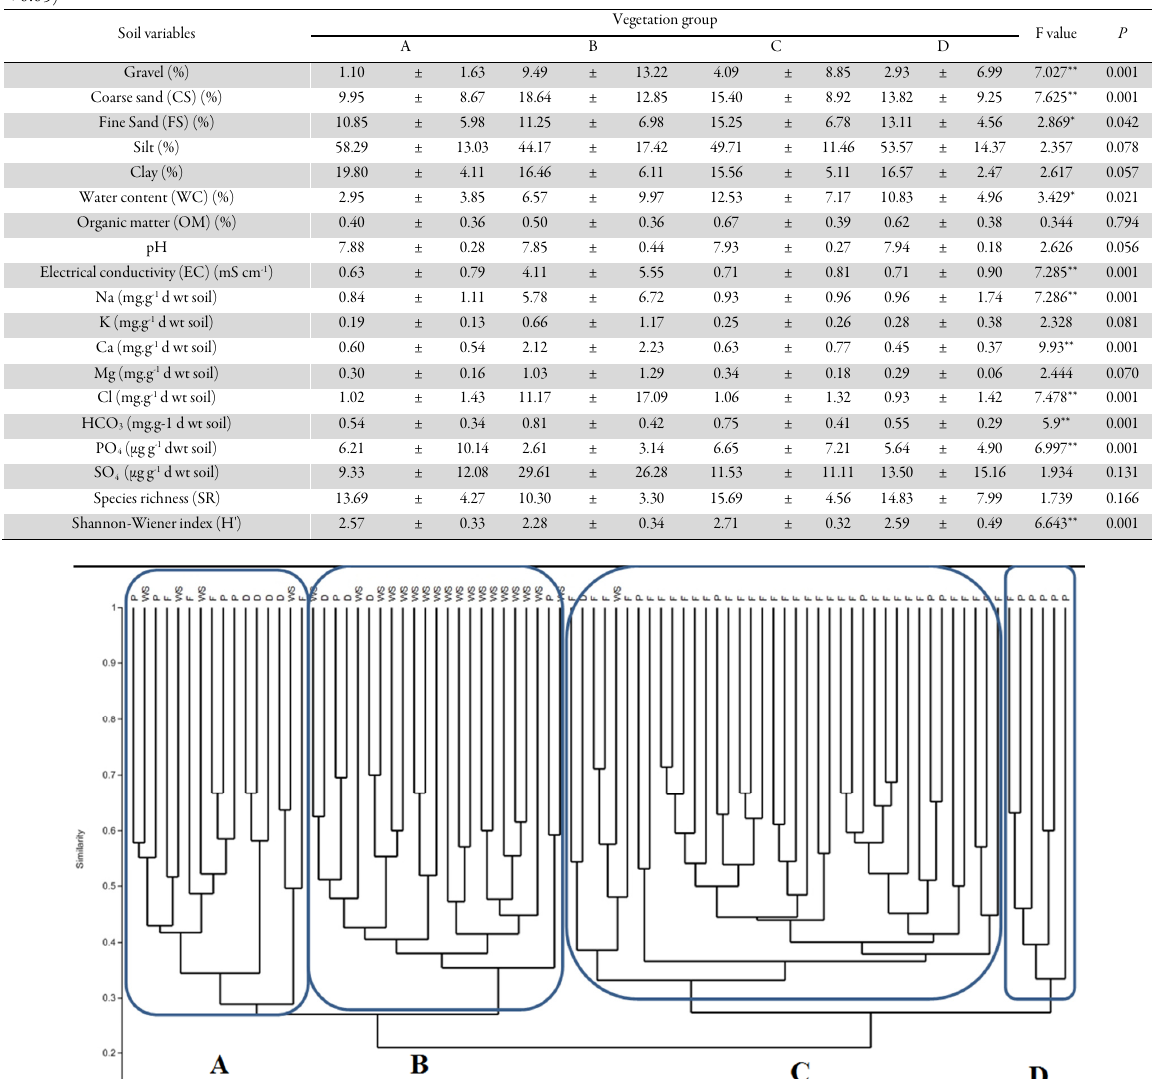
Vegetation group